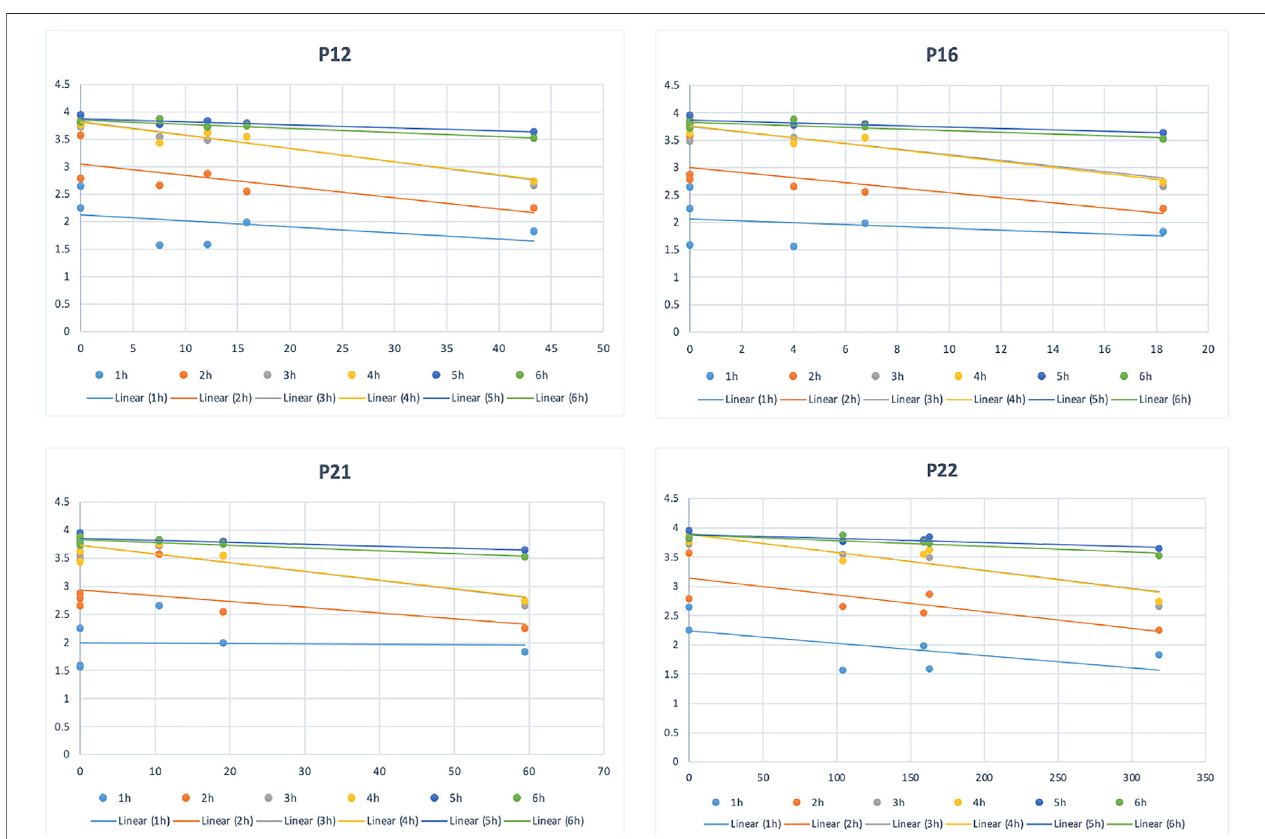
FIGURE 3 | Scatterplot of some correlation peaks and drug ef fi cacy